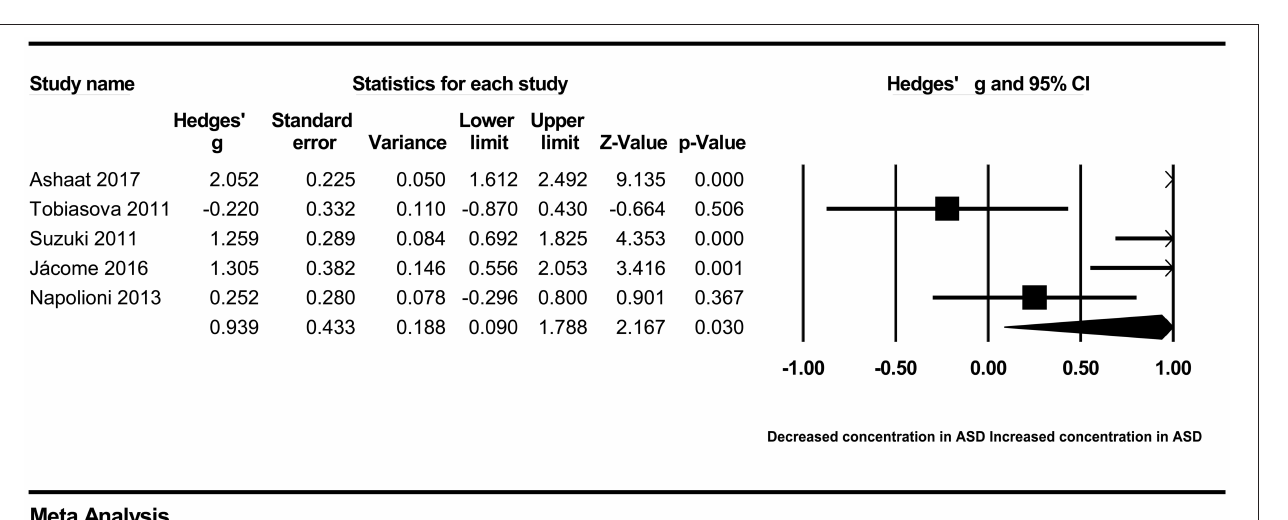
FIGURE 5 | Forest plot for the random-effects meta-analysis (MIF).